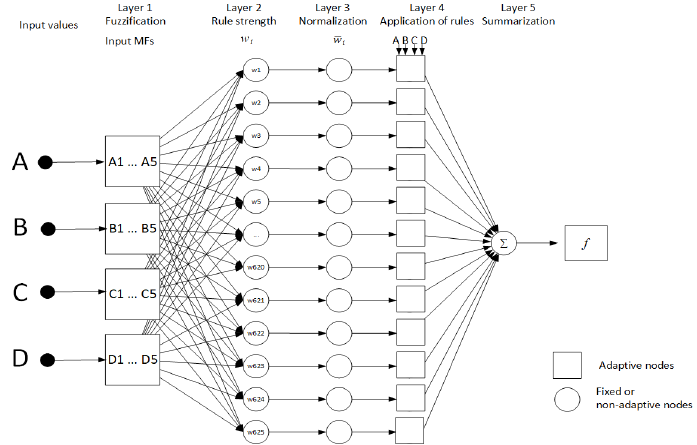
Figure 6. The proposed ANFIS network structure for oil spill prediction.